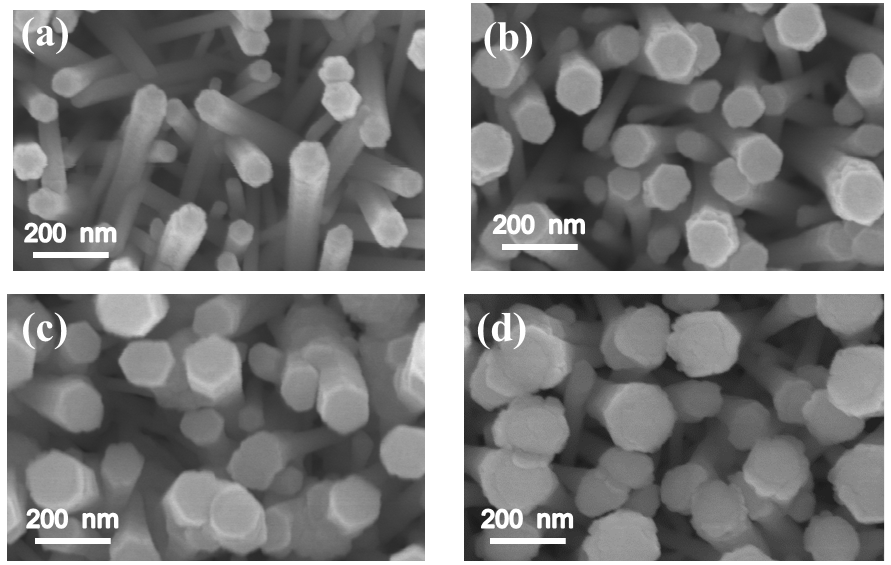
Figure 1. SEM images of ZnO-ZnS core-shell nanorods with various ZnS sputtering durations: ( a ) 10 min; ( b ) 20 min; ( c ) 40 min and ( d ) 60 min.